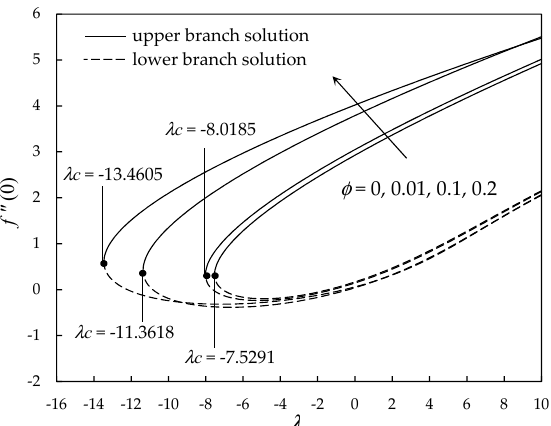
Figure 2. Variation of the reduced skin friction coefficient f (cid:48)(cid:48) ( 0 ) with the mixed convection parameter λ for several values of the volume fraction of nanoparticles φ when Nr = 0.1, K = − 0.1, c = − 1 and s = 1 for Cu-water nanofluid.